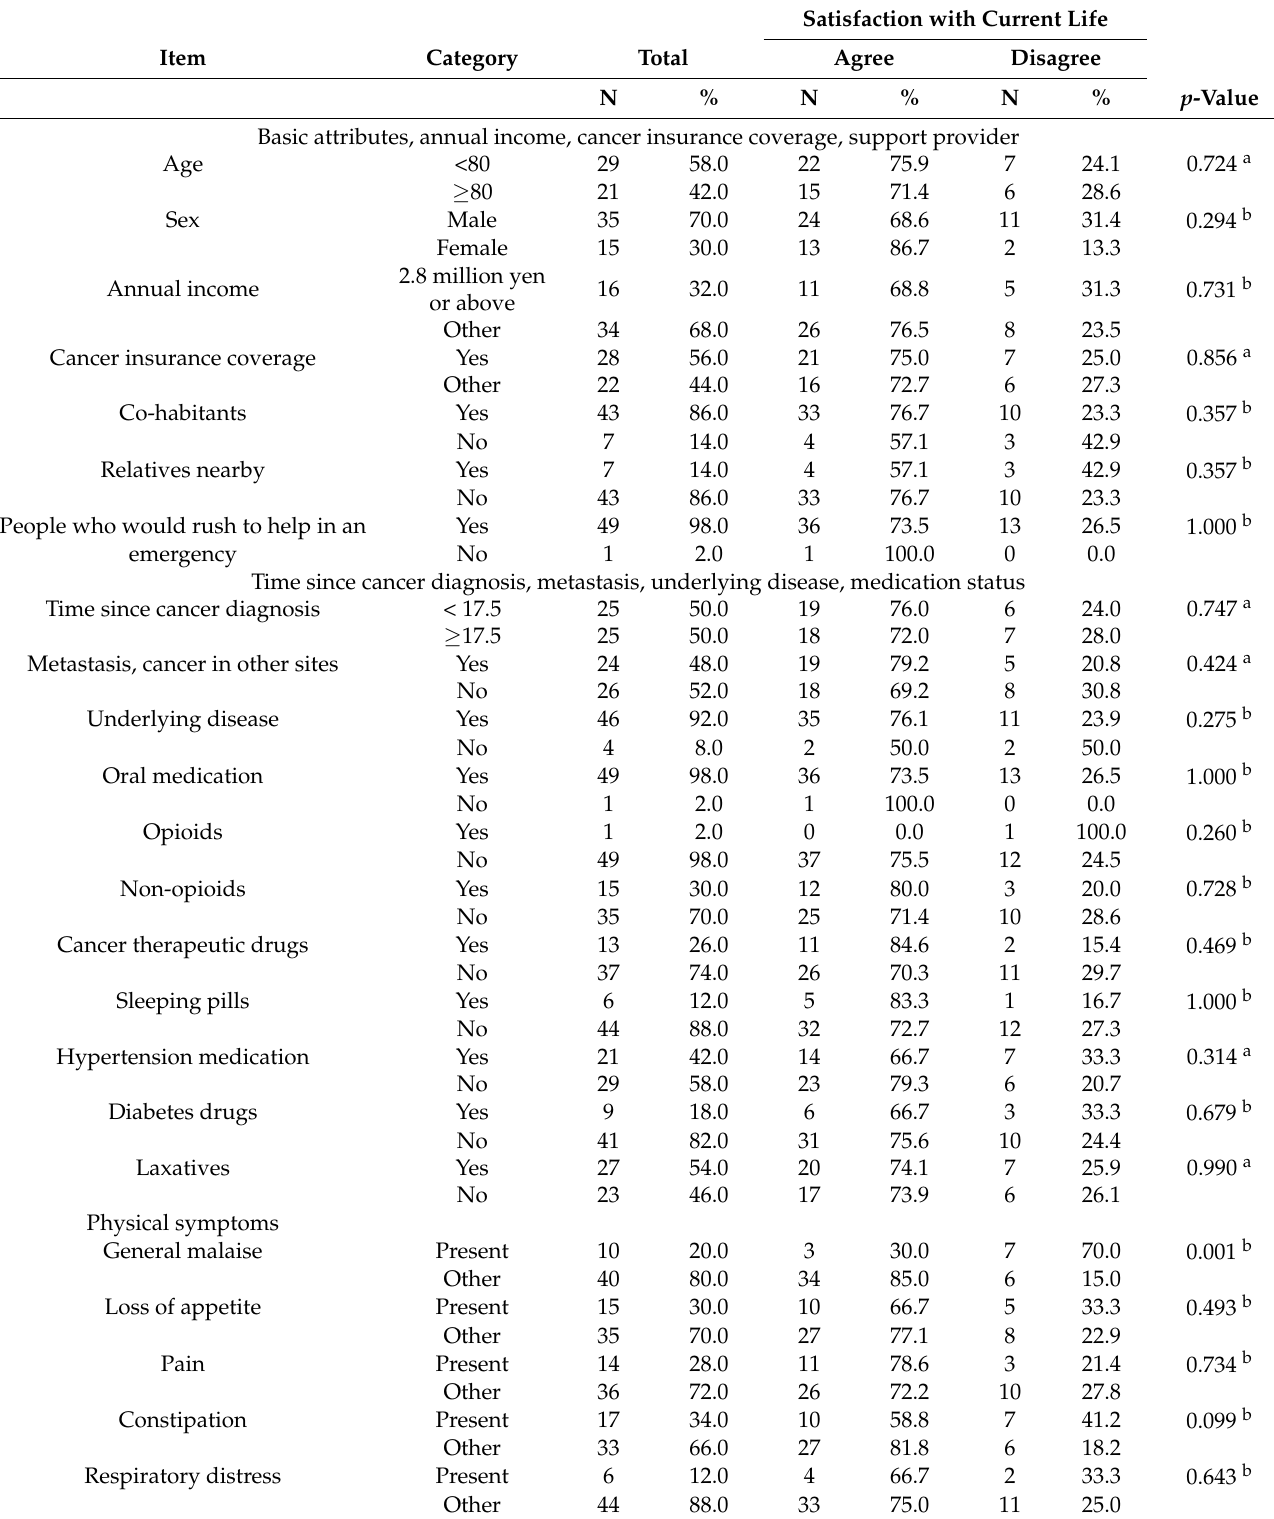
Table 4. Association between the quality of life under treatment and current life satisfaction of cancer